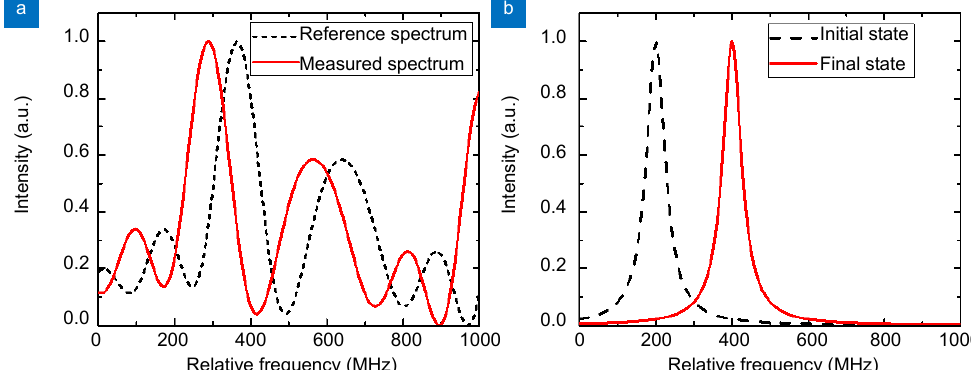
Fig. 3 | ( a ) Simulated Rayleigh intensity distribution along 1 GHz frequency span: reference spectrum (black short dash line) and measured spec- trum (red line). ( b ) The BGSs of the initial state (black short dash line) and final state (red solid line).